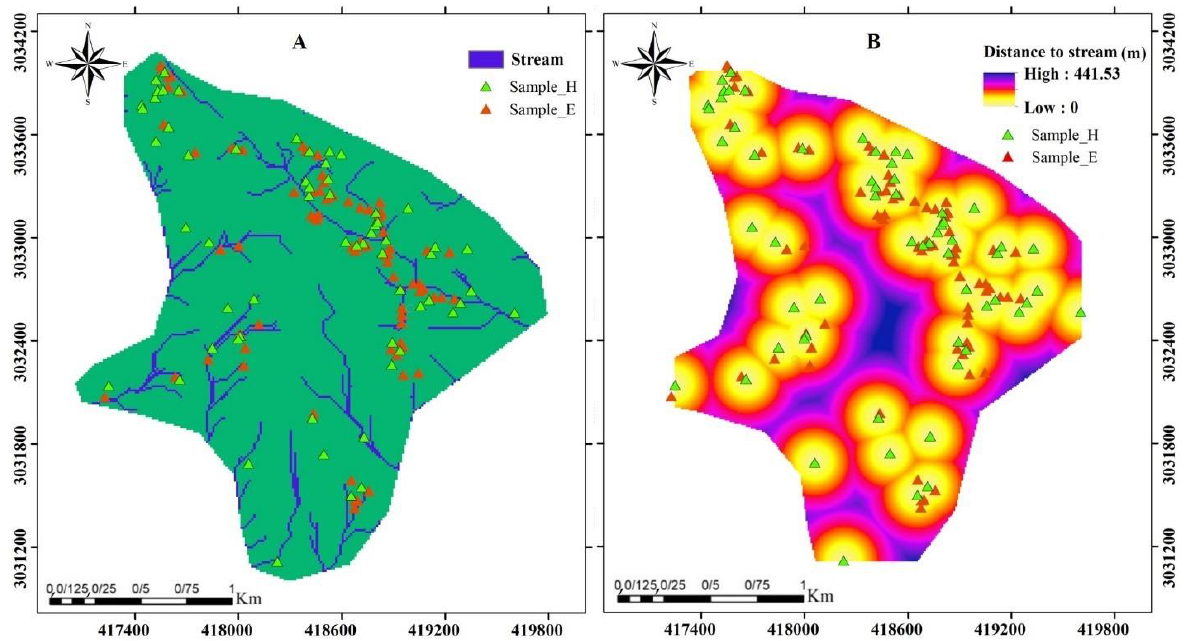
Figure 4. Topographical maps of slope ( A ) and aspect ( B ) of the study area and samples distribution pattern (Sample_H, trees without dried branches; Sample_E, trees with dried branches).